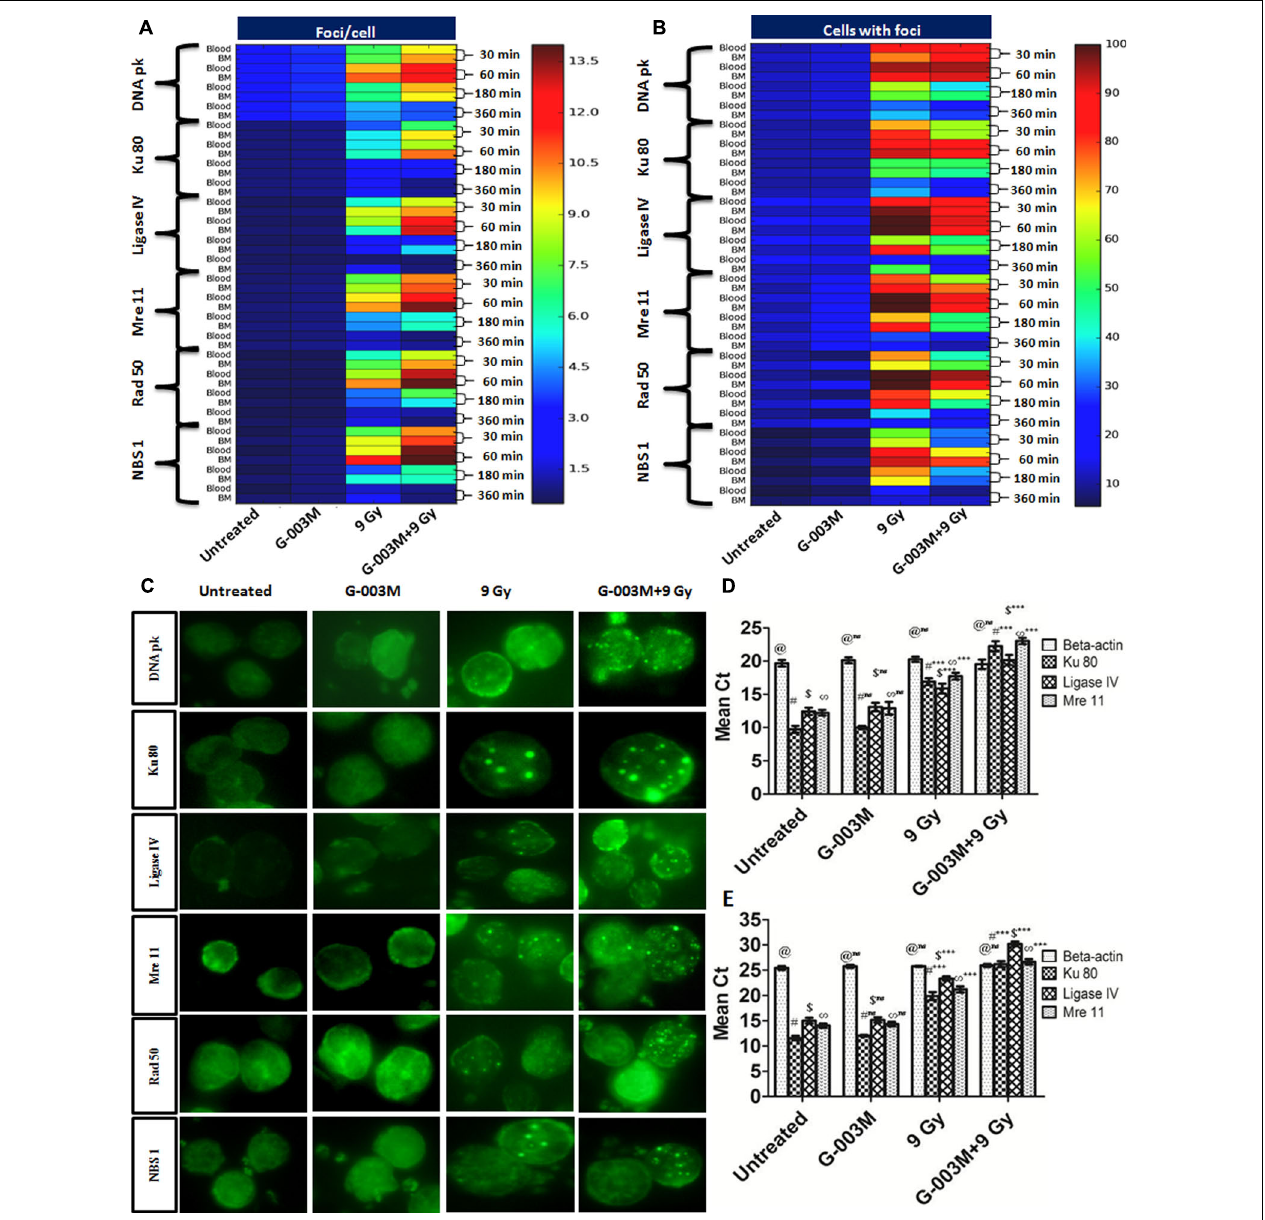
FIGURE 6 | Expression of NHEJ pathway proteins in mice blood and bone marrow populations observed at various times after exposure in the different treatment groups: (A) The heat-map represents the foci number of DNA pk, Ku 80, Ligase IV, MRE 11, Rad 50 and NBS 1at different treatment group at different time interval, i.e., 30, 60, 180, and 360 min and (B) represents the foci distribution of each protein in the blood and bone marrow cells. (C) Representative images of radiation induced foci formation in different treatment group. (D) Graphs represent quantitative real time PCR analysis of Ku 80, Ligase IV and Mre 11 along with the housekeeping gene ( β -actin) at 1 h time points in blood. (E) Graphs represent quantitative real time PCR analysis of Ku 80, Ligase IV and Mre 11 along with the housekeeping gene β -actin at 1 h time points in bone marrow cells of mice. n = 6 per